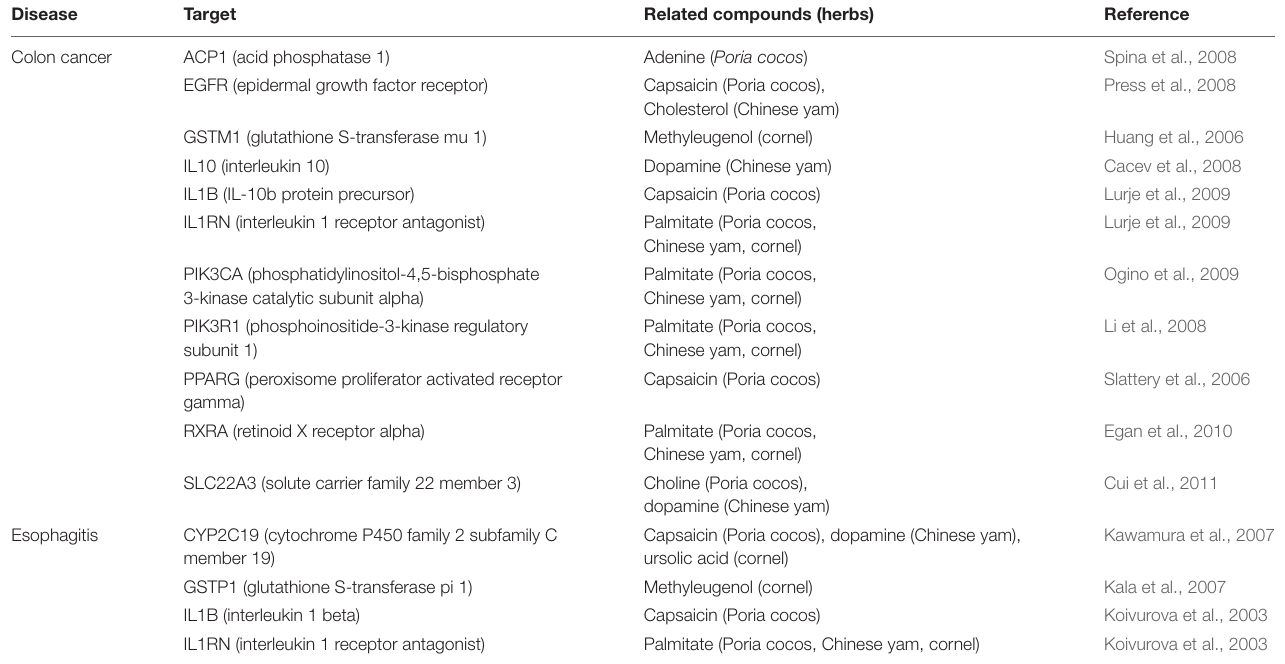
TABLE 4 | Candidate targets of LWDHW for colon cancer and esophagitis validated by TCM-Mesh.